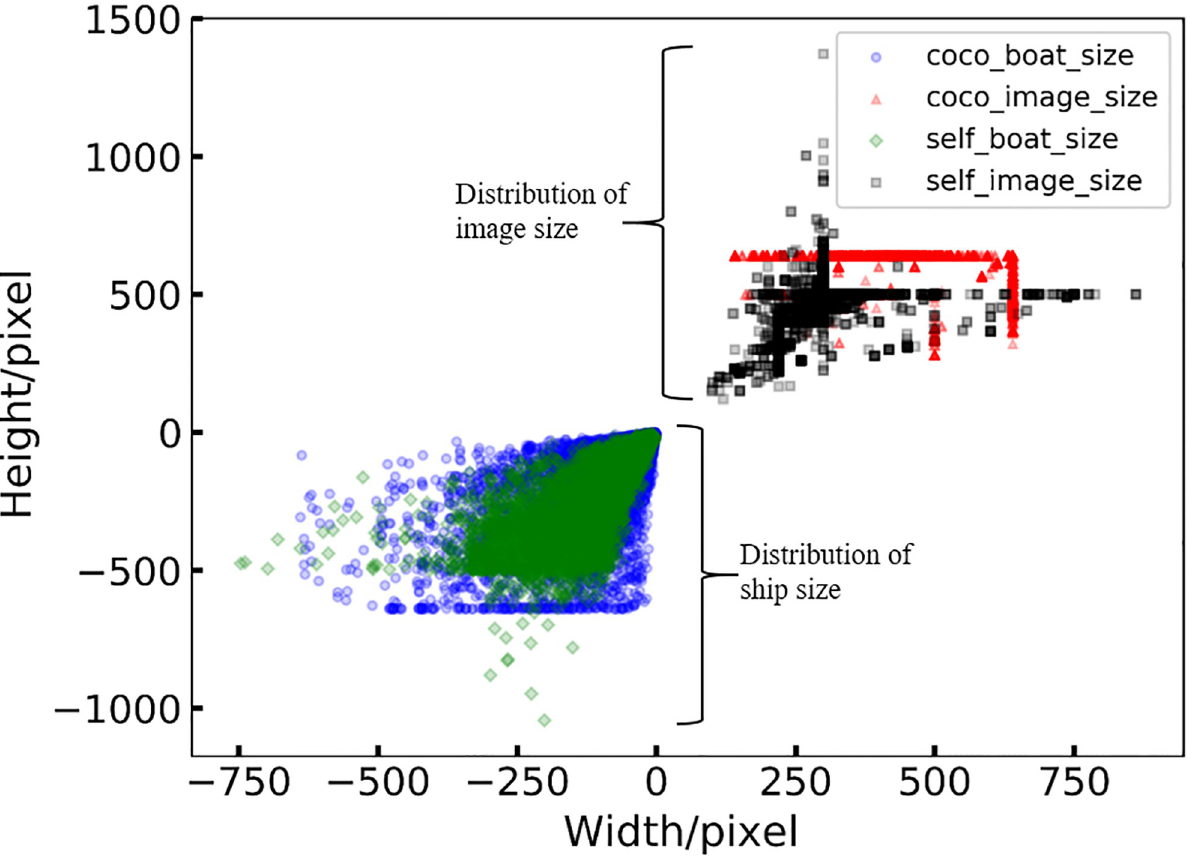
Fig 5. The distribution of image and ship sizes in the MariBoats dataset. It is a combination of Figs 2 and 4.